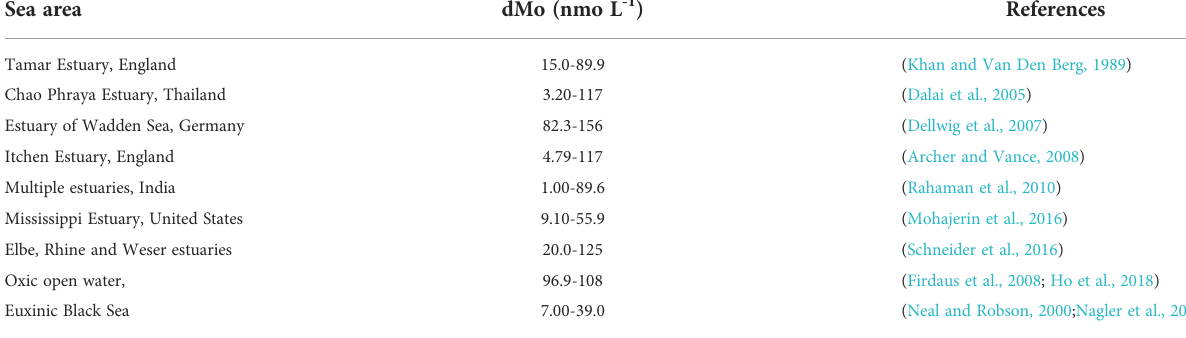
TABLE 1 Dissolved molybdenum concentrations in estuaries and open seas in the world. Sea